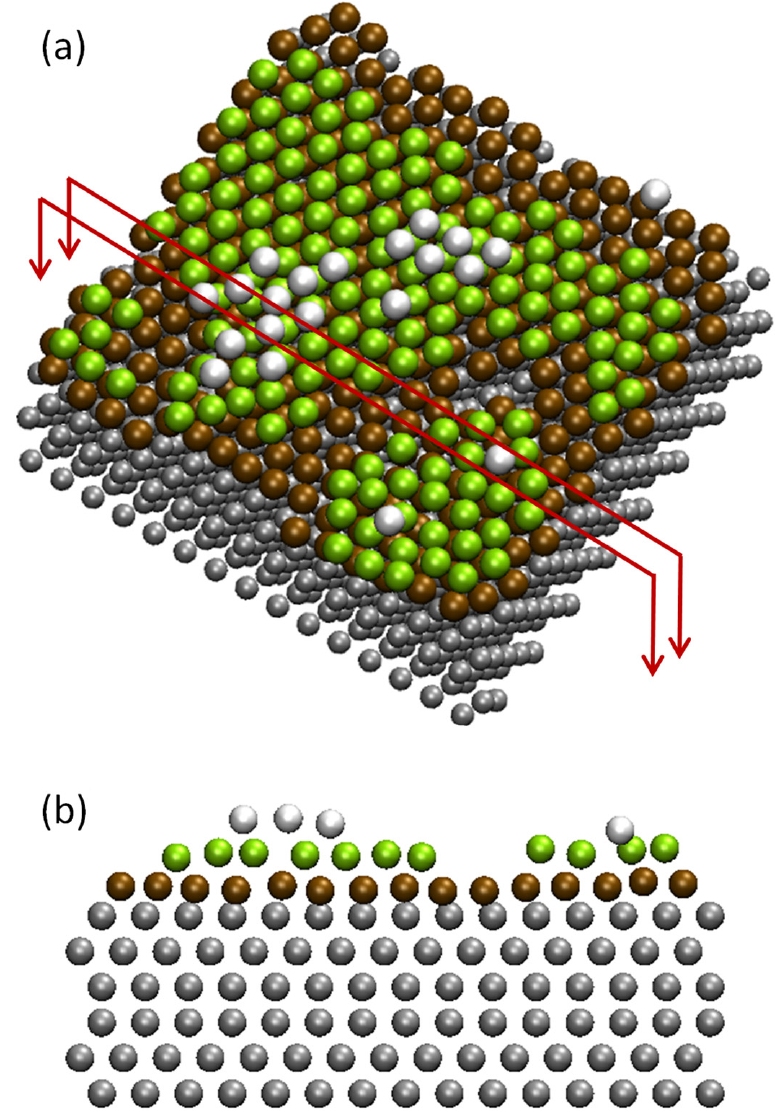
Figure 2. Two-dimensional (2D) ordered structure and diffuse liquid/substrate interface. ( a ) A snapshot of the simulation system with − 2% misfit equilibrated at 900 K showing the 2D ordered structure formed on the surface of the substrate; and ( b ) front view of a slab, taken from the position marked in ( a ), showing the ordered atoms in a diffuse interface between the liquid and the substrate. The results were obtained by local bond-order analysis. The light spheres represent the solid-like atoms in the interfacial layers (ochre, green, and white online for L1, L2, and L3, respectively), and the dark (grey online) spheres represent the substrate atoms.